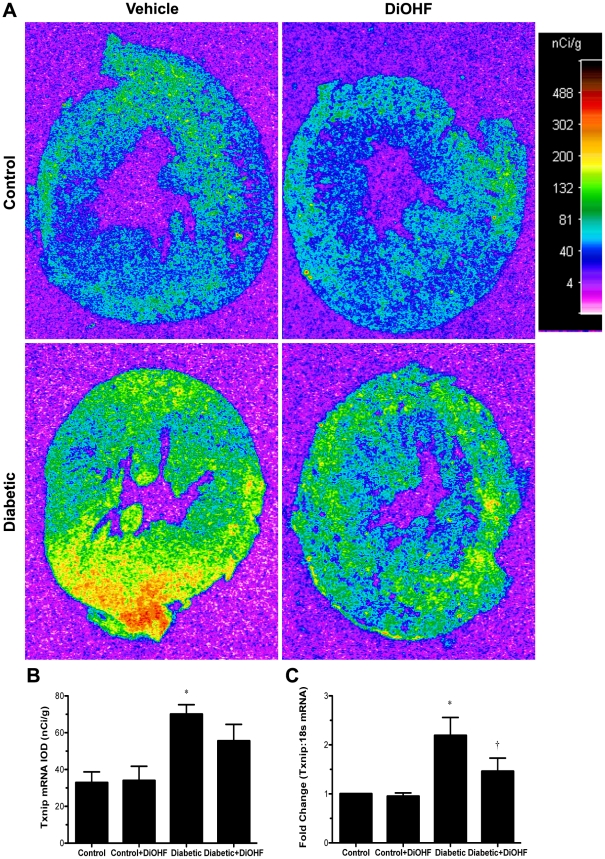
Txnip mRNA gene expression.(A) Representative autoradiographs from in situ hybridization of Txnip. The magnitude of gene expression is indicated quantitatively as a pseudocolourized computer image (blue, nil; green, low; yellow, moderate; red, high). (B) Quantitation of Txnip gene expression by quantitative autoradiography. (C) Measurement of Txnip mRNA by real time RT-PCR, normalized to the housekeeping gene 18s. Data expressed as mean ± SE. *P<0.05 vs control (non-diabetic) rats; †P<0.05 vs diabetic rats.